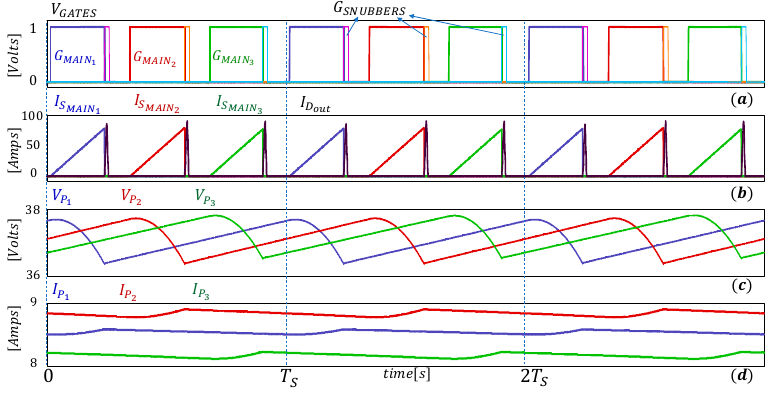
Figure 14. Simulated waveforms: ( a ) Main and snubber switches gate control signals. ( b ) Main switches drain currents and output diode current. ( c ) PV panels’ voltage. ( d ) PV panels’ current.